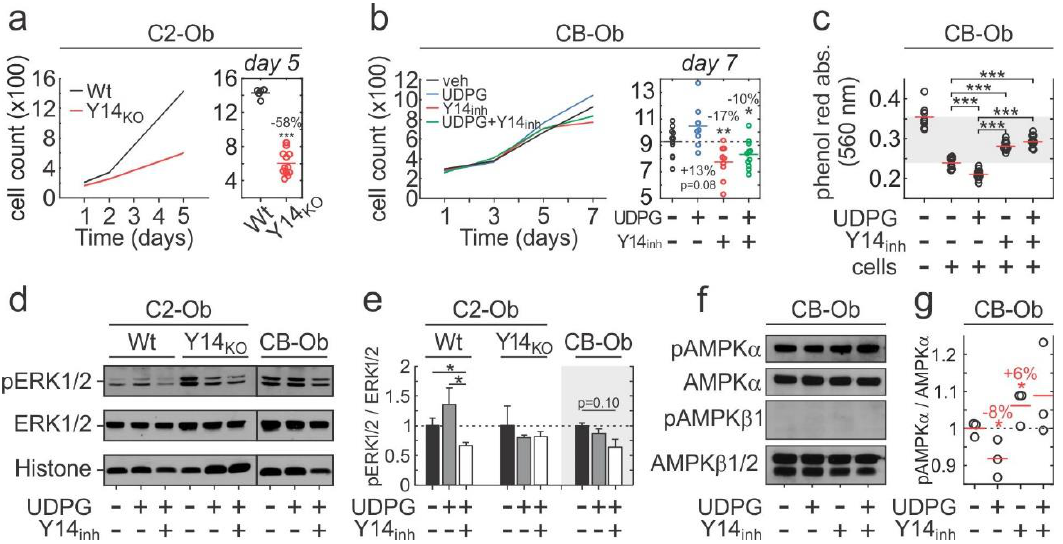
Figure 4. P2Y 14 regulates osteoblast proliferation. ( a,b ) C2-Ob ( a ) and CB-Ob ( b ) cells were plated at equal densities, cultured for the indicated number of days, formalin-fixed, and DAPI-stained. The number of cells / field was counted at specified days. Raw data (day 5 for C2-Ob, a —right panel; day 7 for CB-Ob, b —right panel) and means are shown, n = 5–12 independent cultures. ( c ) Absorption (560 nm) of phenol red in conditioned media sampled from CB-Ob cultures at day 7 was evaluated by spectrophotometry. Shaded gray region: Region between positive ( + cells) and negative (- cells) control. Raw data and means are shown, n = 9–11 independent cultures. (d,e) Immunoblot ( d ) and analysis ( e ) of phosphorylated and total ERK1 / 2 in C2-Obs and CB-Obs pretreated with ( + ) or without ( − ) 100 nM PPTN (Y14 inh , 10 min) and stimulated with 10 µ M UDPG (15 min). Data are means ± sem, n = 3 independent cultures. ( f,g ) Immunoblot ( f ) and analysis ( g ) of AMPK α and AMPK β 1 / 2 phosphorylation in CB-Obs after 48 h pre-treatment with or without Y14 inh and / or 100 µ M UDPG. Raw data and means ± sem are shown; n = 3 independent cultures. Significance assessed by t-test with Bonferroni correction; p < 0.05 * and p < 0.001 ***.